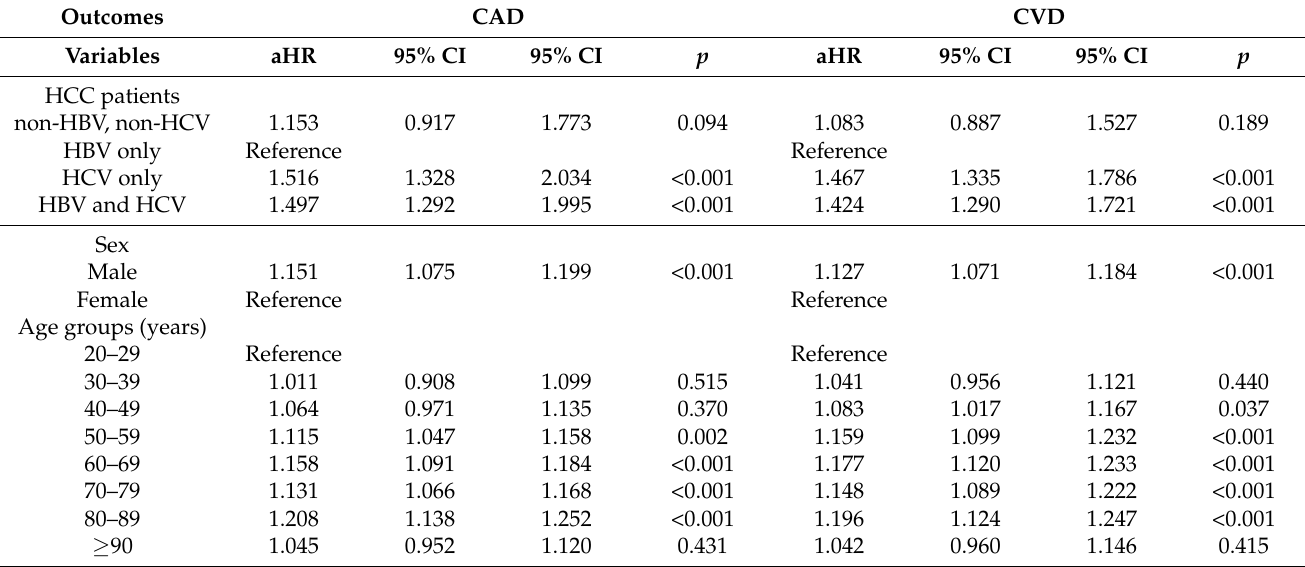
Table 2. Factors of CAD/CVD by using multivariable Cox